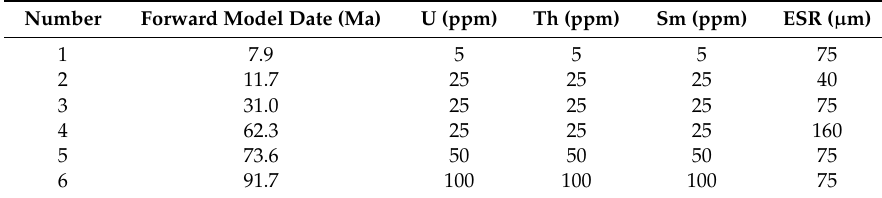
Table 1. Synthetic data and corresponding forward model date from HeFTy. Each forward model date was computed by HeFTy using the input values of U, Th, Sm, grain size, and the following three-point thermal history: (1) 15 ◦ C at 100 Ma, (2) 75 ◦ C at 10 Ma, and (3) 15 ◦ C at 0 Ma. ESR is equivalent spherical